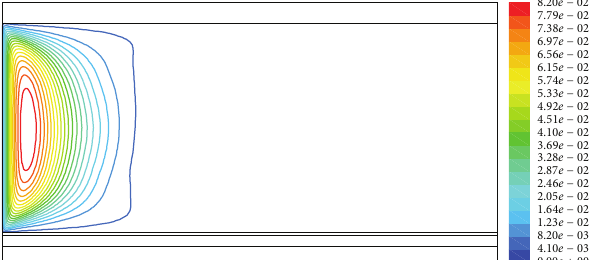
Figure 8: Contours of stream function field.